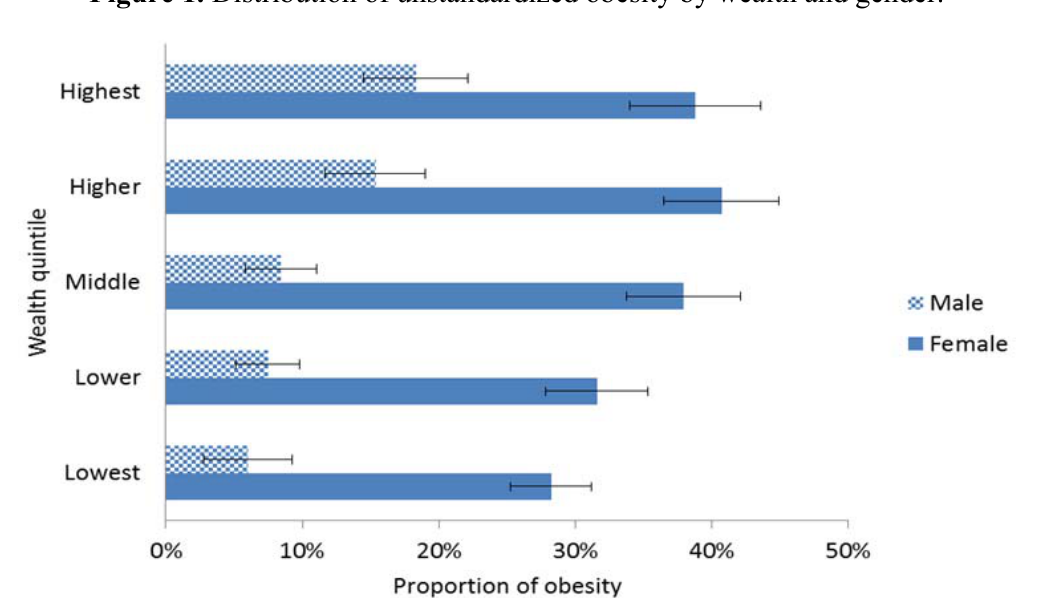
Figure 1. Distribution of unstandardized obesity by wealth and gender.